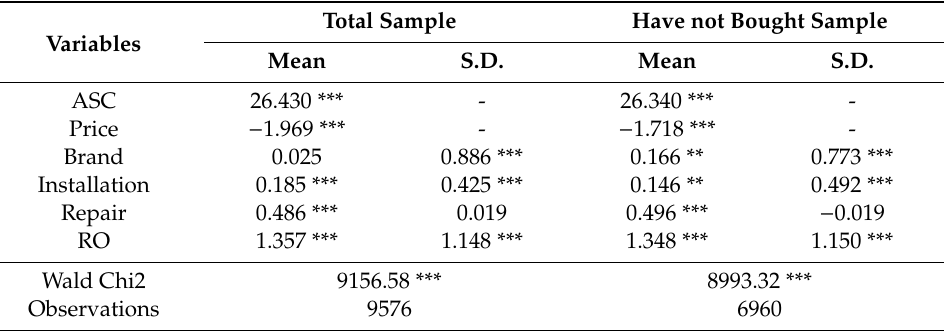
Table 4. The results of mixed logit